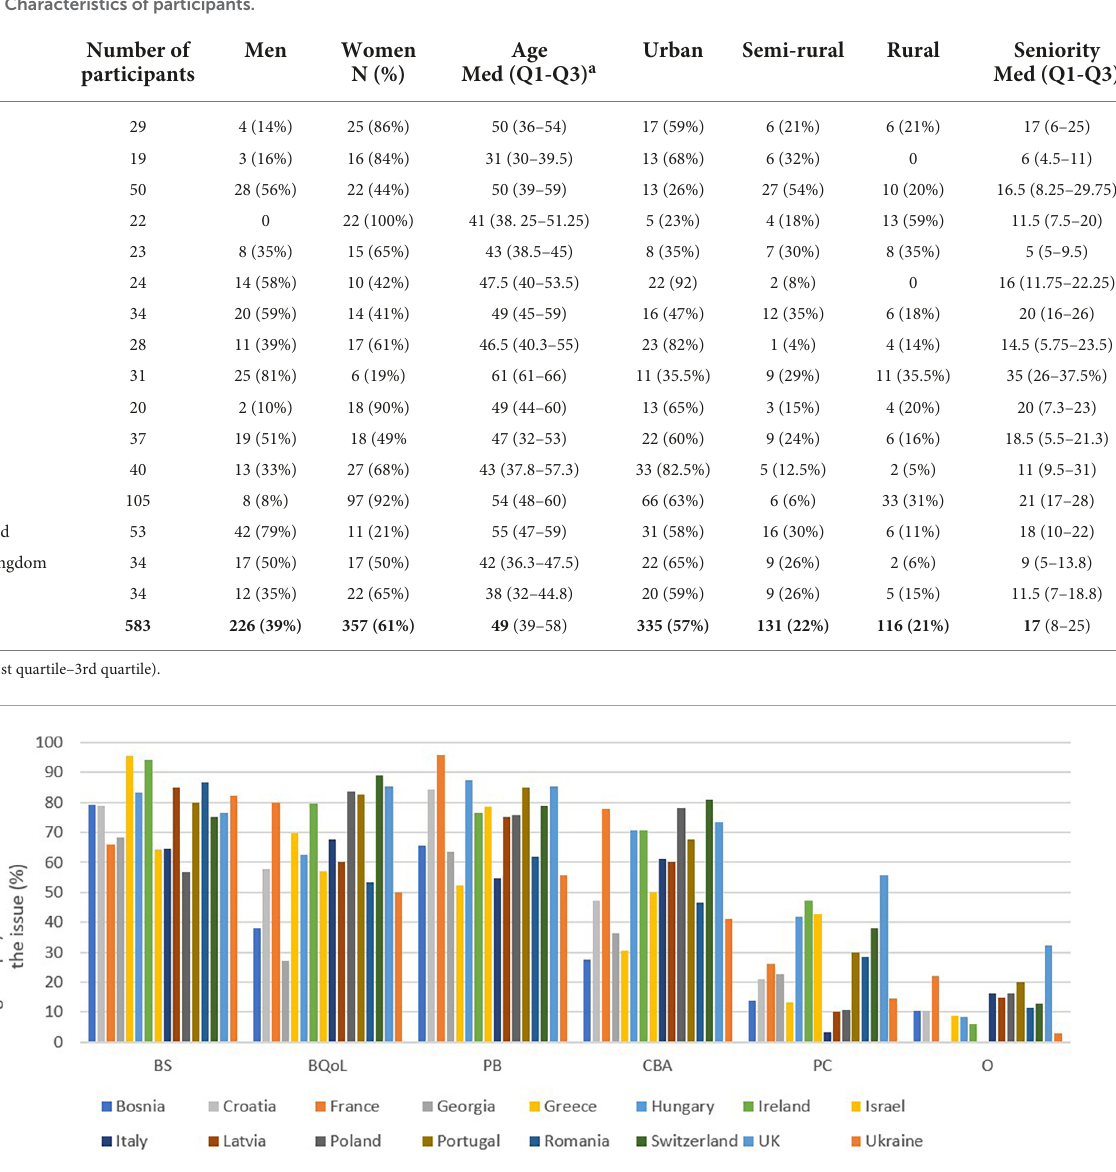
FIGURE2 Intermediate care: Main benefits declared by general practitioners. BS, Better support; BQoL, Better quality of life; PB, Prevention of burnout; CBA, A break and assistance for the caregiver; PC, Respect for the patient’s choice; O,